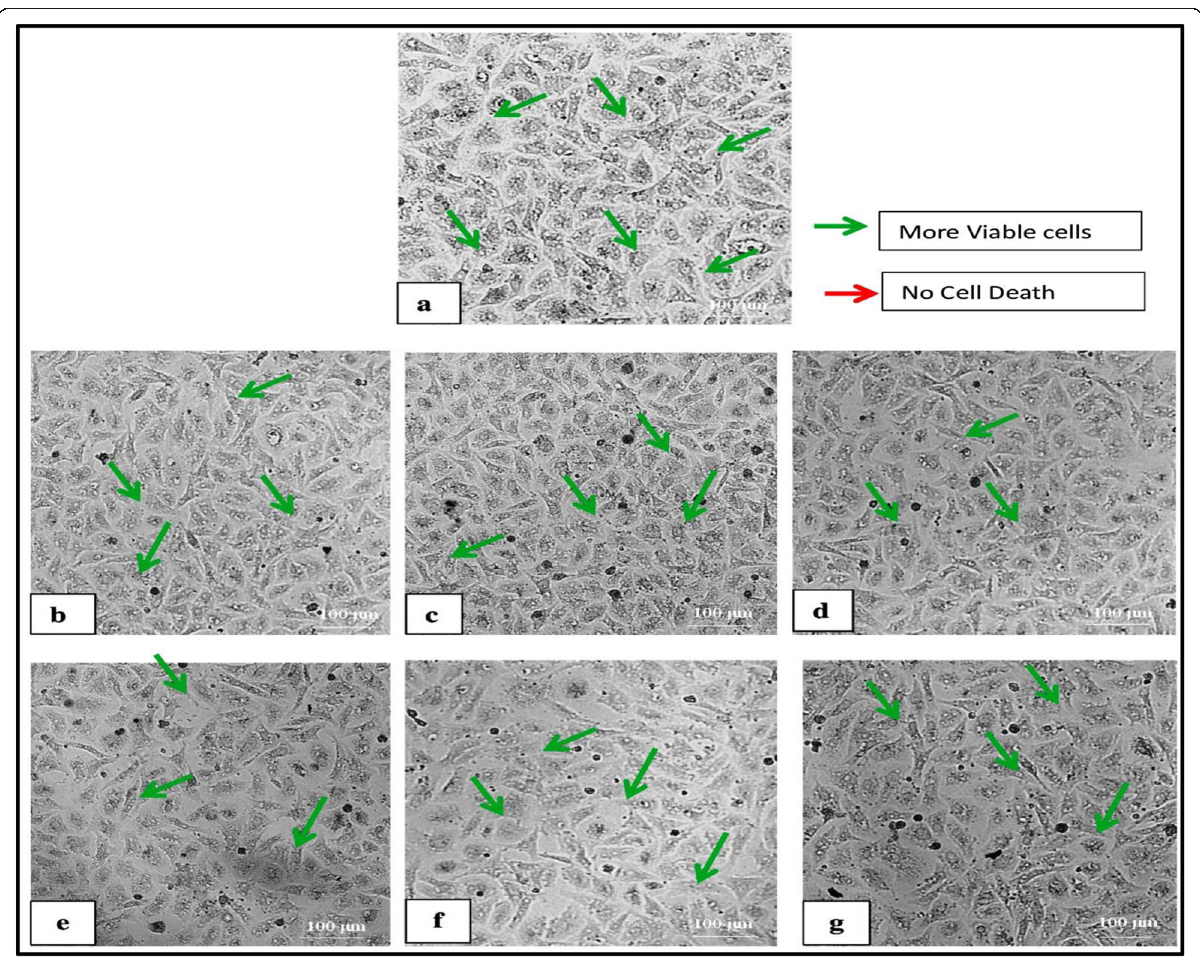
Fig. 1 Morphological profile of the Vero cells after treated with ethyl acetate extract of Clerodendrum thomsoniae Balf 1.0 μ g/mL ( b ), 10 μ g/mL ( c